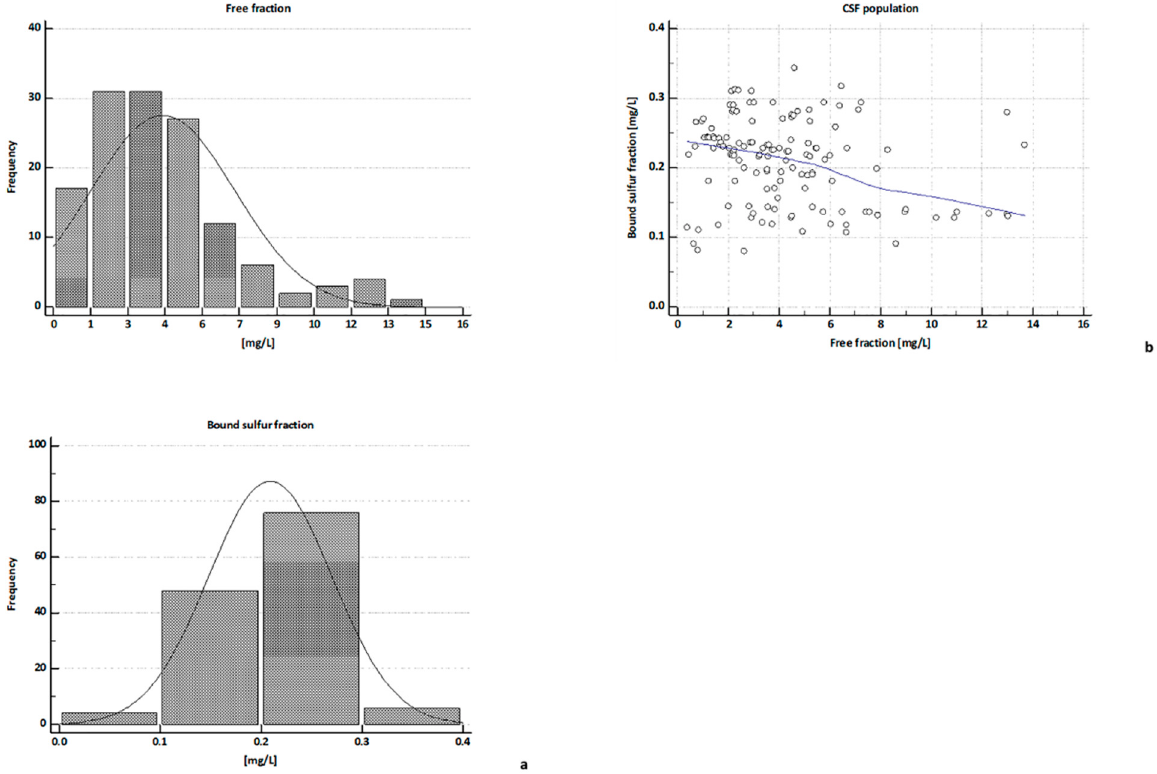
Figure 2. Distribution of H 2 S measurements across the CSF population. All the data collected from IC analysis, were analyzed with MedCalc statistical software; distribution plots, obtained using the non-parametric Kolmogorov–Smirnov (K-S) test, were shown for both fractions free and bound sulfur, respectively, at top and bottom of the figure (Panel ( a )). Pearson’s analytical test does not show any correlation comparing the free H 2 S measurements with the bound H 2 S levels (Panel ( b )).